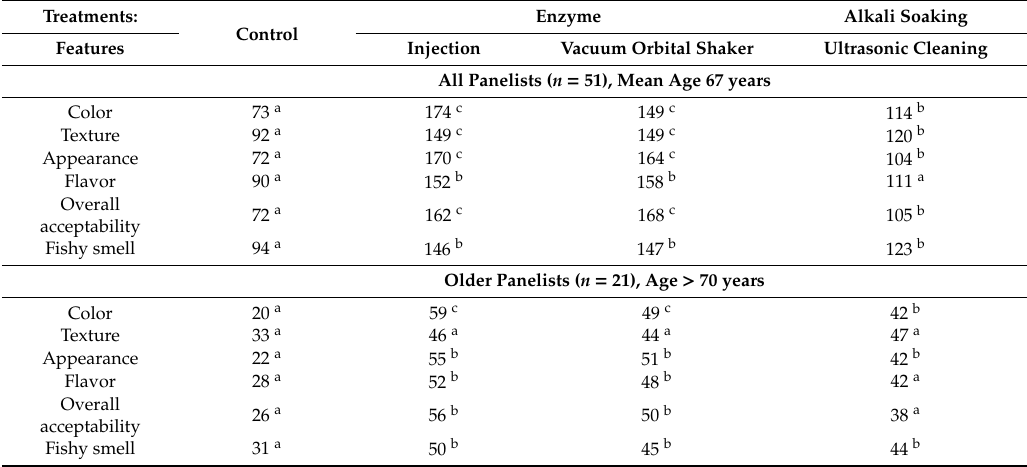
Table 8. Sensory evaluation of neritic squid by panelists. Results for each feature are expressed as sums of individual scores ranging from 1 to